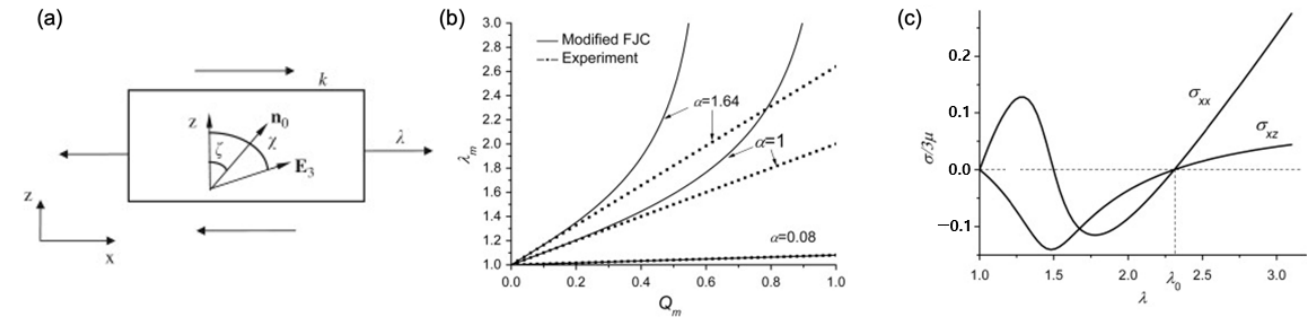
Figure 6. Phase behaviors predicted by Jin et al. ( a ) Uniaxial stretch 𝜆 of a LCN material of nematic director 𝑬 𝟑 ; ( b ) spontaneous deformation 𝜆 𝑚 induced by LC order collapse 𝑄 𝑚 ; ( c ) the non-monotonic correlation between normalized stress ( 𝜎/3𝜇 ), in both stretched ( 𝜎 𝑥𝑥 ) and transverse ( 𝜎 𝑥𝑧 ) directions, and the given stretch (λ) observed during the uniaxial stretch when 𝜁 = 15° (Adapted with permission from Ref. [57]. 2010, Jin, L.).